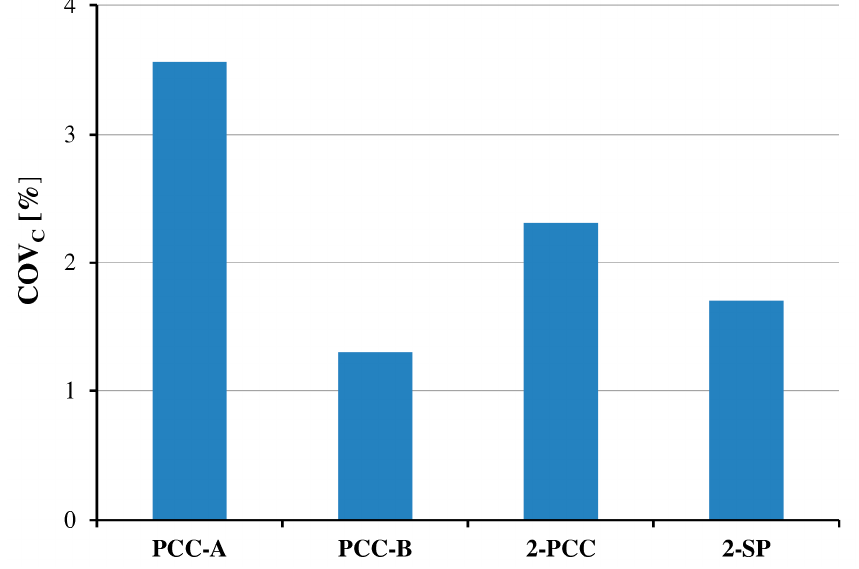
Figure 6. Variance of peak pressure COV C for different ignition systems.